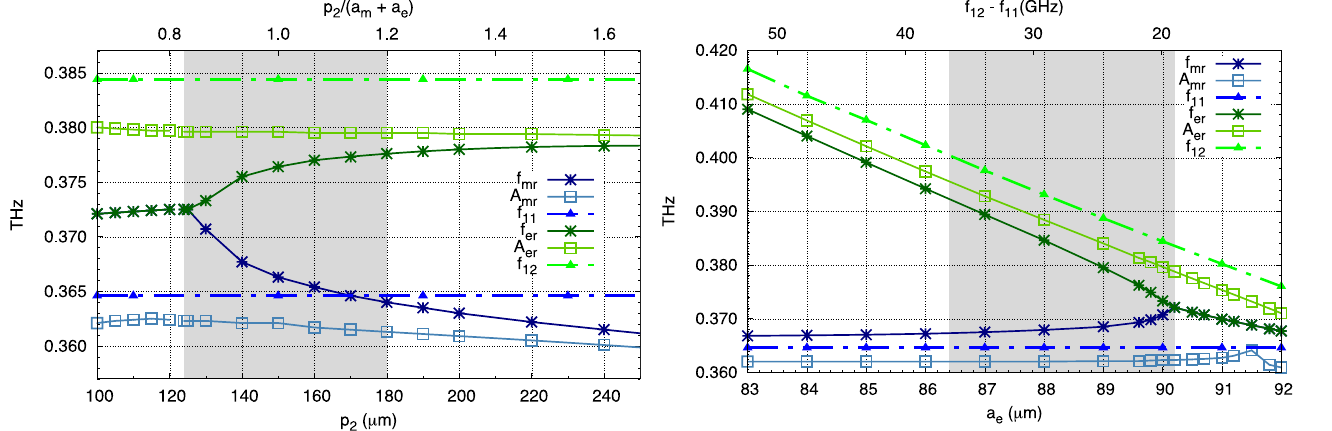
Fig. 7. Frequency mode coupling: frequency of the fi rst two modes of Mie resonances ( f mr , f er ) as a function of the side length a e of the electric resonator, namely, the frequency of the electric mode is varying. The convention is the same as in Figure 6. The side length of the magnetic resonator is a m =60 m m and the lattice period l p is 260 m